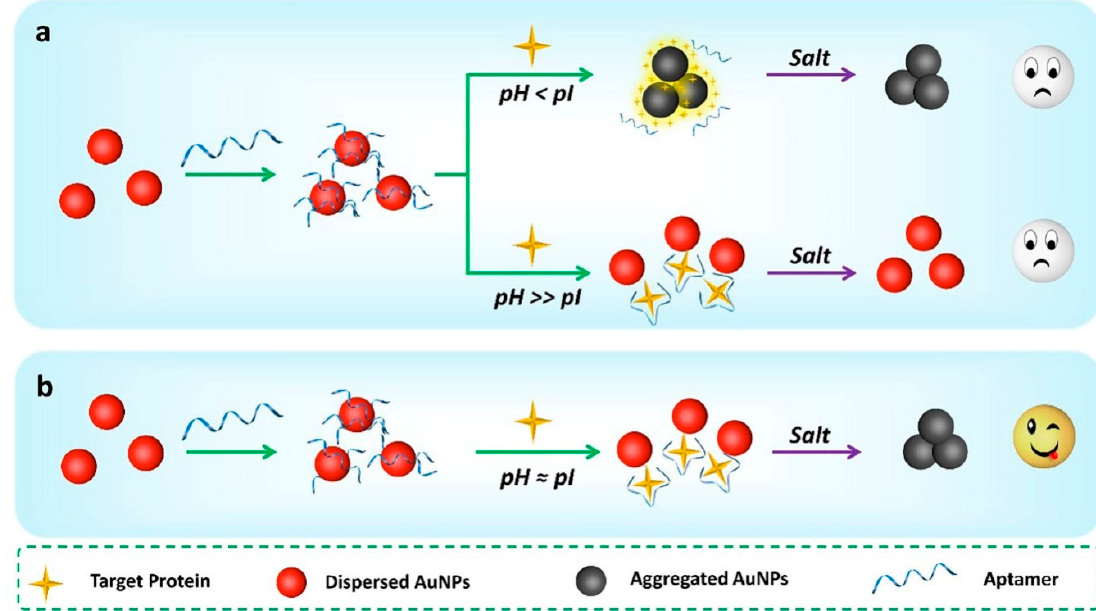
Figure 1. Overview of the pH-dependent unmodified gold nanoparticles-based aptasensing (uGA) assay for protein detection. ( a ) At pH < isoelectric points (pI), the proteins directly induce the aggregation of unmodified gold nanoparticles (AuNPs) in the absence of salt; at pH >> pI, the proteins do not induce the aggregation of AuNPs even in the presence of salt. ( b ) The pH near the pI of protein can be used to implement the uGA assay because the aggregation of AuNPs is not affected by the charge of the protein but can be triggered by adding salt in this situation.